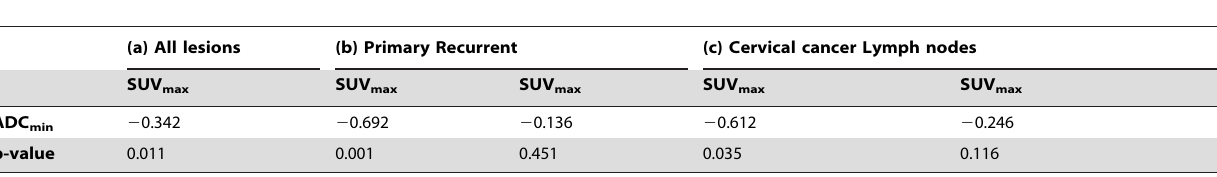
Table 1. Correlations of the maximum Standardized Uptake Value (SUV max ) and the minimum Apparent Diffusion Coefficient (ADC min